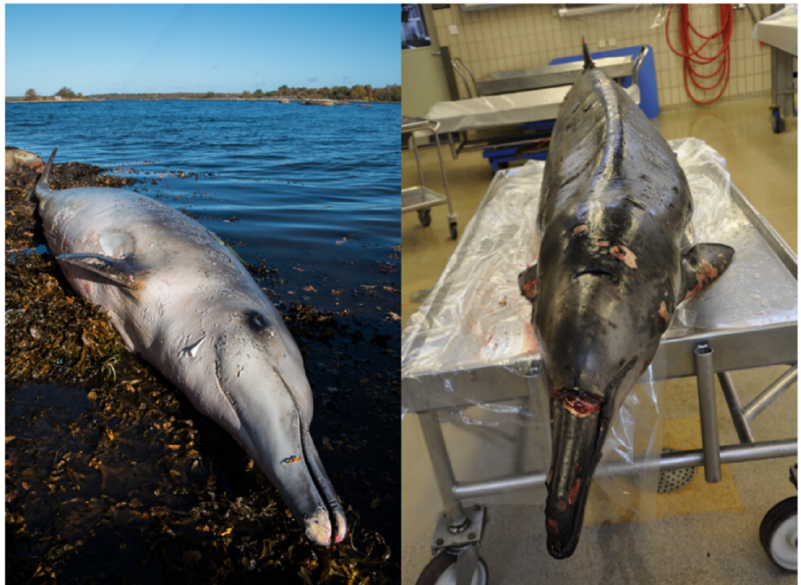
Figure 4. The Sowerby’s beaked whale ( Mesoplodon bidens ) that was found in June 2015 (Specimen 1) was emaciated and had severe atrophy of the epaxial muscles along its back. Photo: Robert Ekholm ( left ) and SVA ( right ).